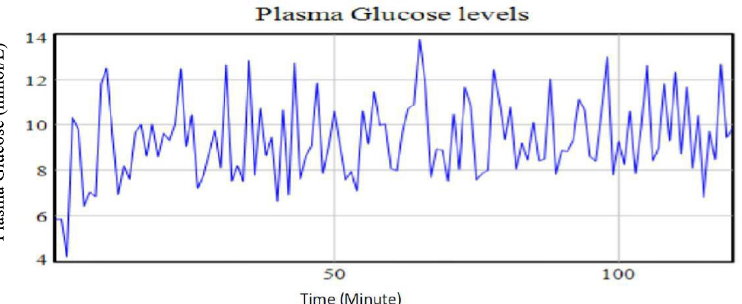
Figure 10. Plasma glucose levels using identified parameters for the extended Bergman Minimal Model for a type II diabetic patient with reduction in the physical exercise intensity.